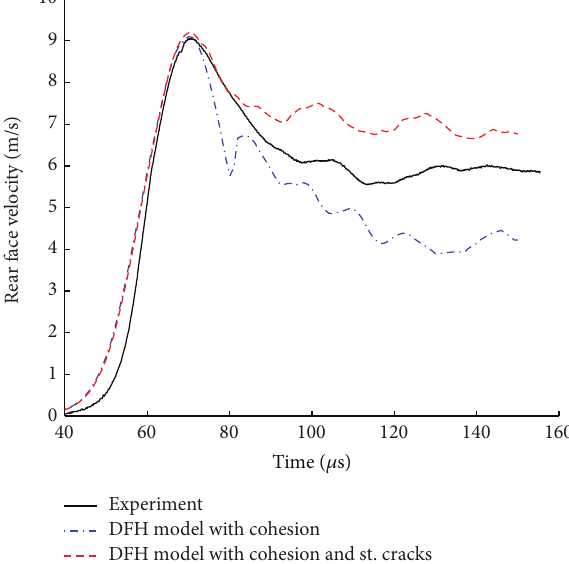
Figure 12: Finite element and experimental spalling test results. Preexisting structural cracks are present in the